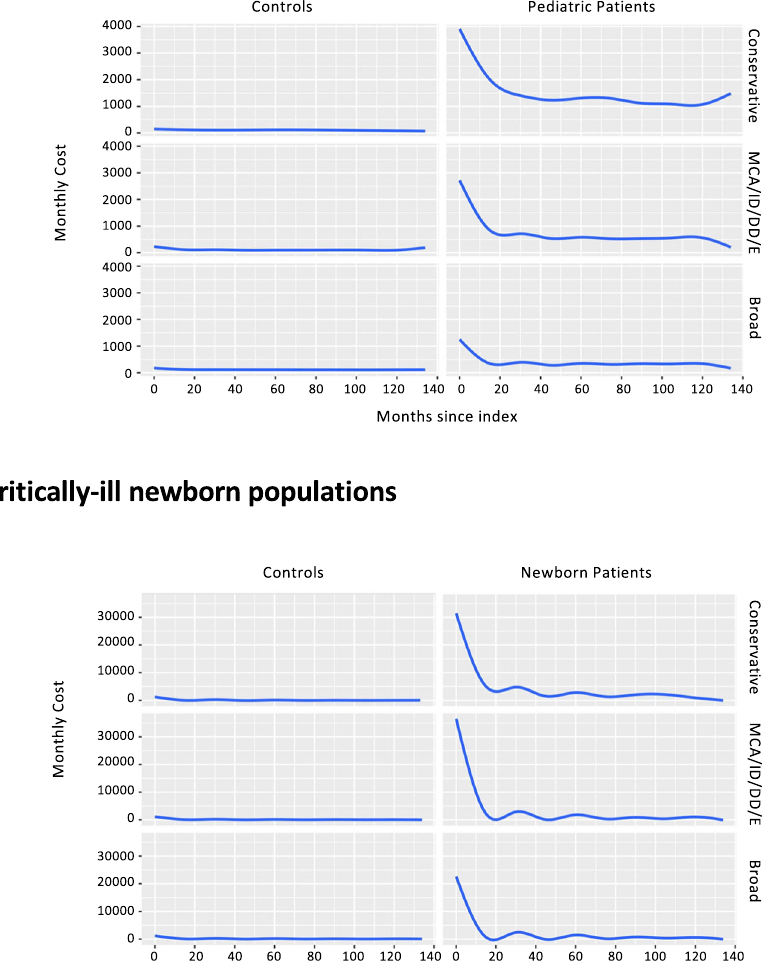
Fig. 2 Monthly costs from index date. For both the a pediatric populations and b critically-ill newborn populations, control populations are shown on the left and patient cohorts on the right. MCA/ID/DD/E: MCA multiple congenital anomalies, ID intellectual disability, DD developmental delay, E